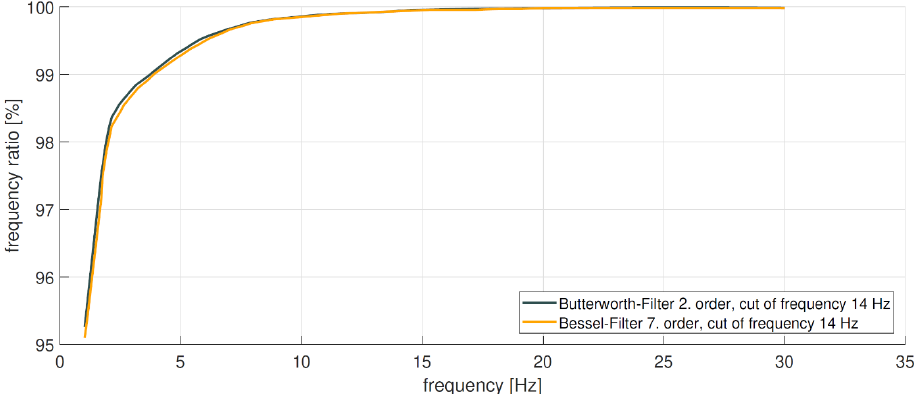
Figure 11. Representation of the mean frequency components of the entire spectrum per Hz in percent (blue) after processing the CoP track with a Butterworth second order filter (black) and a Bessel seventh order filter (orange), where the respective cut-off frequency was 14 Hz.